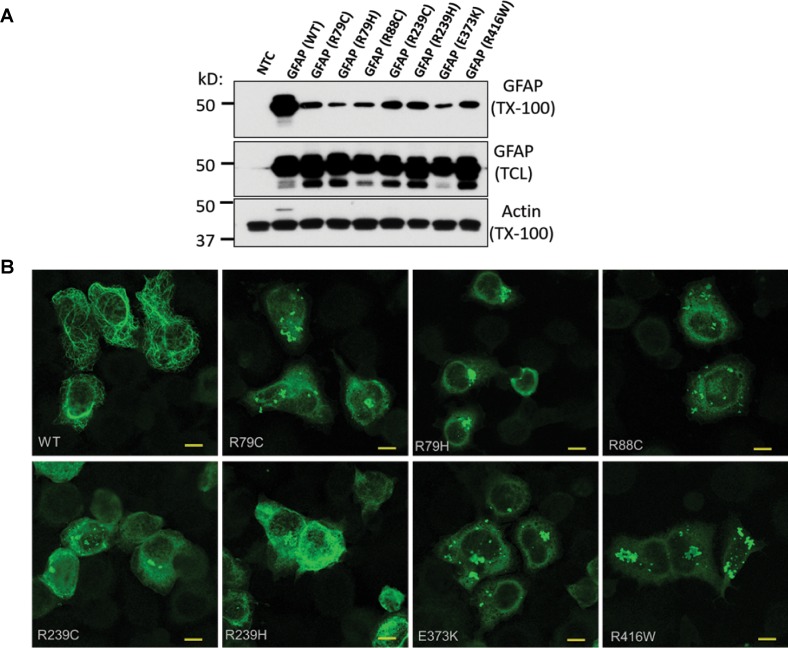
Optimization of transient expression for WT and AxD-associated GFAP mutant proteins in SW13vim- cells.(A) Western blot of SW13vim- cells transfected for 24 hr with the designated GFAP constructs. NTC, non-transfected control. Top and bottom blots show GFAP and pan-actin, respectively, in the Triton X-100-soluble fraction (TX-100). Middle blot is a total cell lysate (TCL) blot of GFAP from the same transfections. (B) Corresponding immunofluorescence staining of GFAP in SW13vim- cells after 24 hr of transfection. Scale bars = 10 µm.